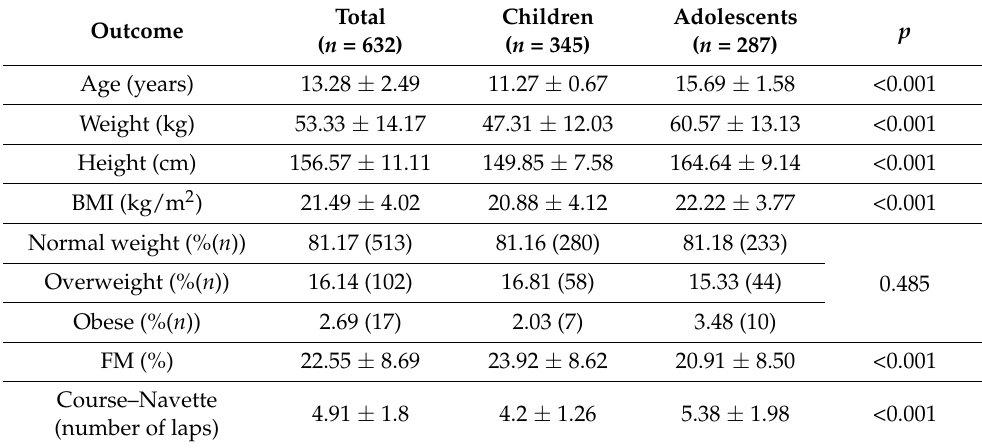
Table 1. Characteristics of the study sample and differences between age groups (children vs.